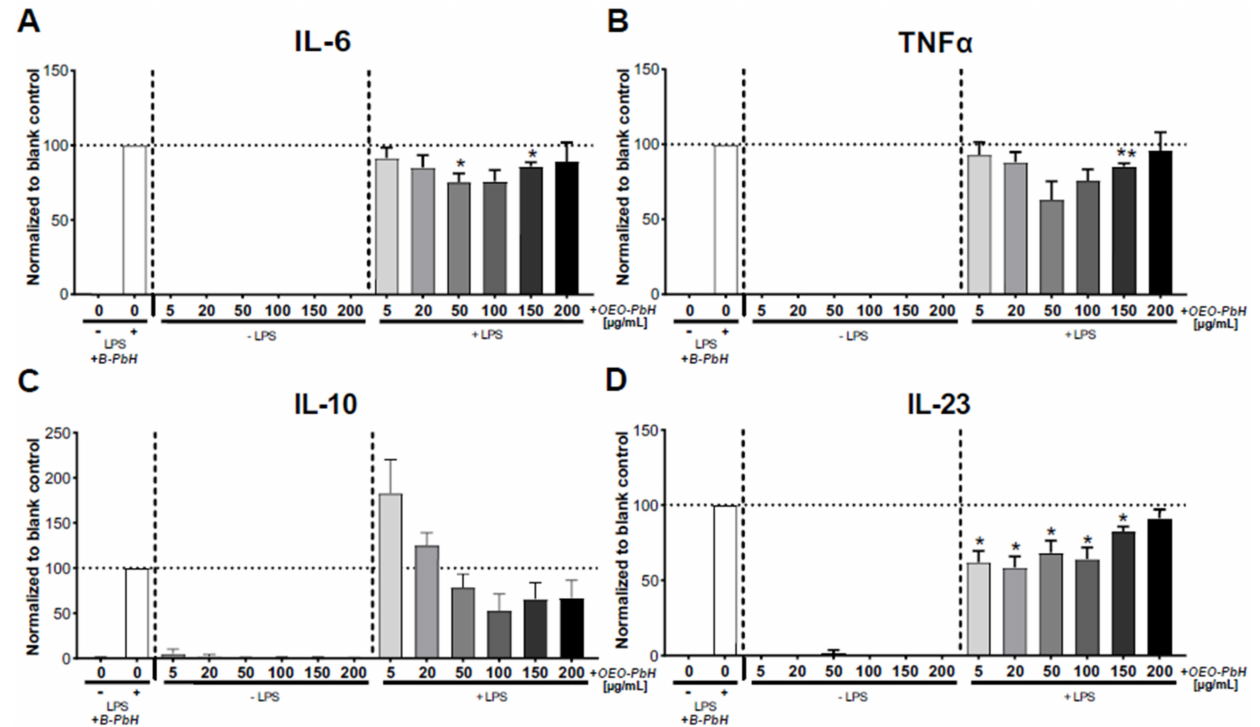
Figure 11. Effects of OEO-PbH on the cytokine production. DCs were cultured for 7 days with GM-CSF and IL-4. Cells were subsequently stimulated without LPS or with LPS and treated with OEO-PbH at different concentrations for 24 h. The DC cell culture supernatant was then ana- lyzed by ELISA for IL-6 ( A ), TNF α ( B ), IL-10 ( C ), and IL-23 ( D ). Data expressed as mean ± SEM ( n = 6 donors); * indicates comparisons to the respective blank control (B-PbH-treated DCs) using RM one-way ANOVA (* p < 0.05; ** p <